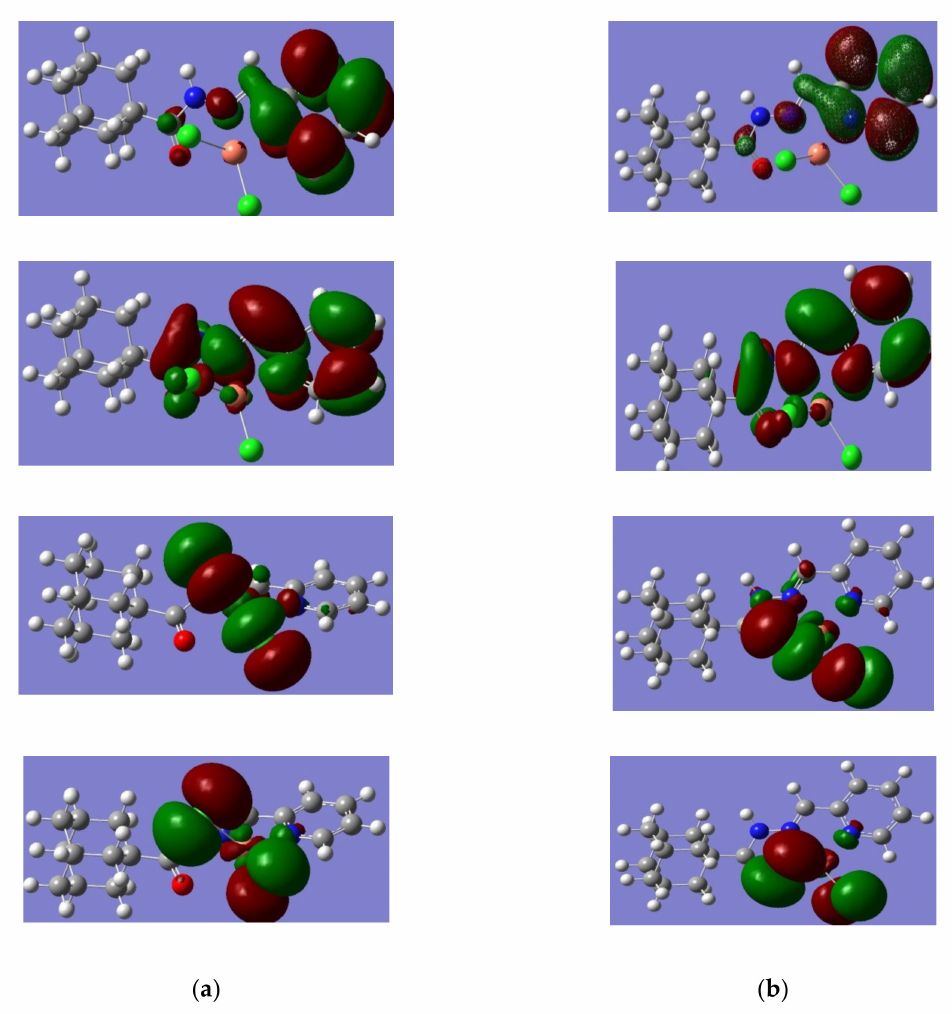
Figure 2. Presentation of the HOMO-LUMO atomic orbital for complex 1a and complex 1b , which are obtained at 6–311 + G(2d, p) / B3LYP level of theory ( a ) HOMO + 1, HOMO, LUMO, and LUMO − 1 for complex 1a ( b ) HOMO + 1, HOMO, LUMO, and LUMO − 1 for complex 1b